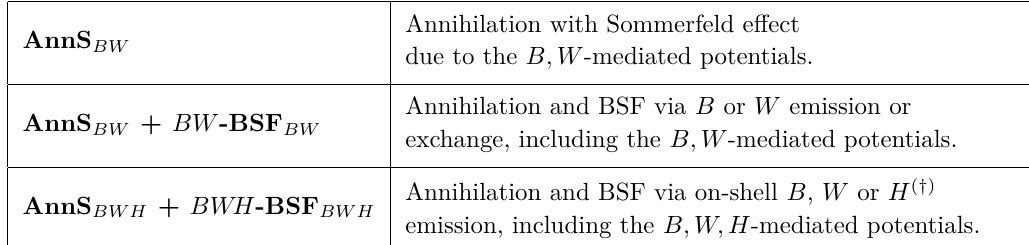
Table 3 . The combinations of effects we compare in the following, in terms of their impact on the DM decoupling. The case of perturbative annihilation only does not differ very significantly from annihilation with Sommerfeld effect, thus we do not present it separately. When considering BSF, we always include both radiative BSF and BSF via scattering. However, we have examined their effects separately, and found that the inclusion of BSF via scattering does not change the results obtained when considering radiative BSF only. Moreover, in the present model, considering the Higgs-mediated potential while omitting BSF via Higgs emission, or the reverse, do not result in a significant effect on the relic density (cf. figure 3), we thus do not present these cases separately.